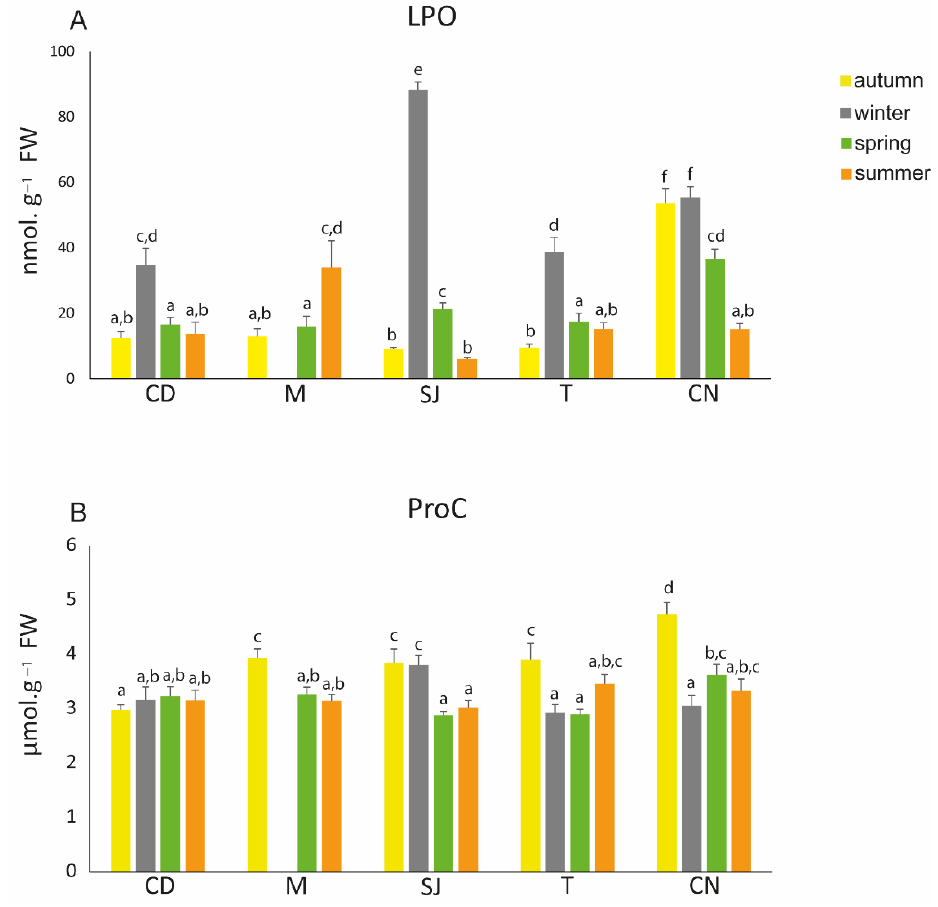
Figure 6. Oxidative damage endpoints: ( A ) lipid peroxidation (LPO) and ( B ) protein carbonylation measured in Diopatra neapolitana in autumn 2018 and winter, spring, and summer 2019. Comparison between different seasons. Letters (a–f) represent significant differences between areas and seasons ( p ≤ 0.05). CD: Cale do Ouro; M: Murtosa; SJ: São Jacinto; T: Torreira; CN: Costa Nova. Site M has no winter data.